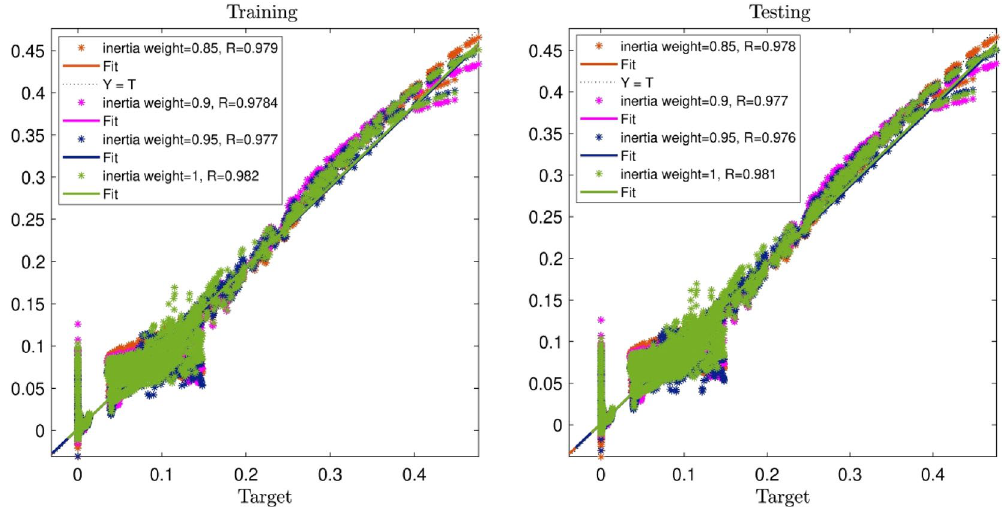
Figure 6. PSOFIS learning processes with considering changes in inertia weight when swarm size is 100 and number of inputs is